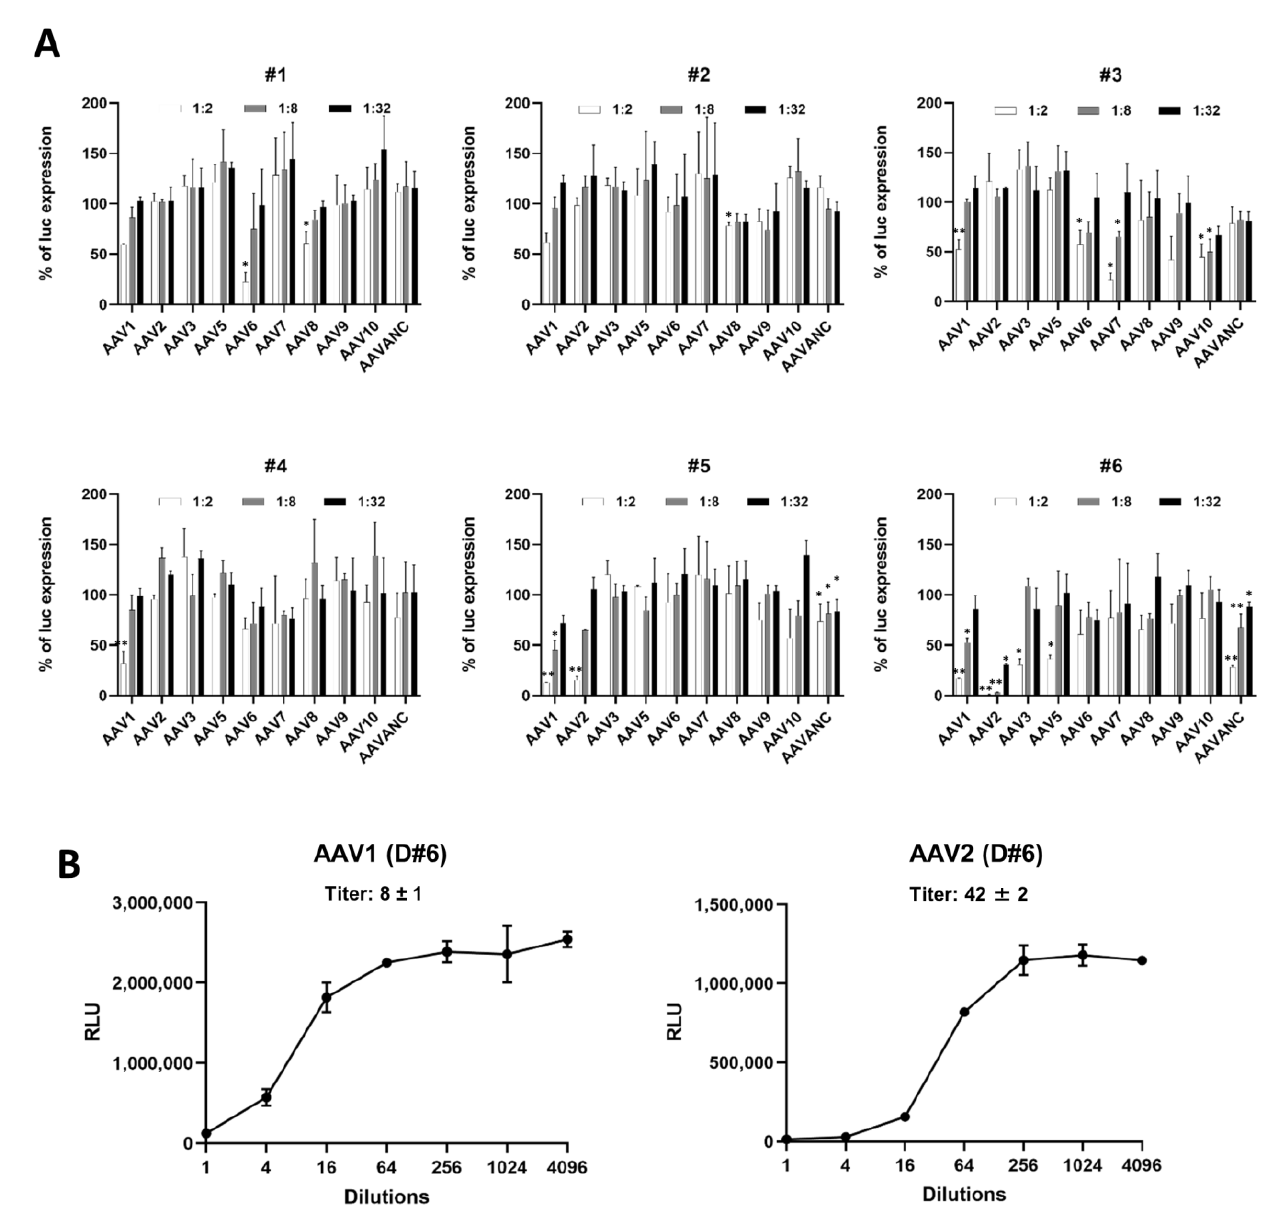
Figure 5. Anti-AAV NAB assay for dog samples. ( A ) Screening for the presence of NABs against 10 AAV serotypes in dog serum samples ( n = 6). Samples were screened as described above in Figures 2 and 4 at dilutions of 1:2, 1:8, and 1:32. Data are presented as the mean ± SD in triplicate. Statistically significant differences are indicated as p * < 0.05, p ** < 0.01 vs. the control. ( B ) NAB titer for AAV1 and AAV2 in dog sample #6 determined at dilutions ranging from 1:2 to 1:4096. Table 2. Summary of AAV NAB profiles for each individual animal subject. Blue, yellow, brown, and red correspond to AAV NAB titers ≤2, 2– 8, 8 –32, and ≥32, respectively.